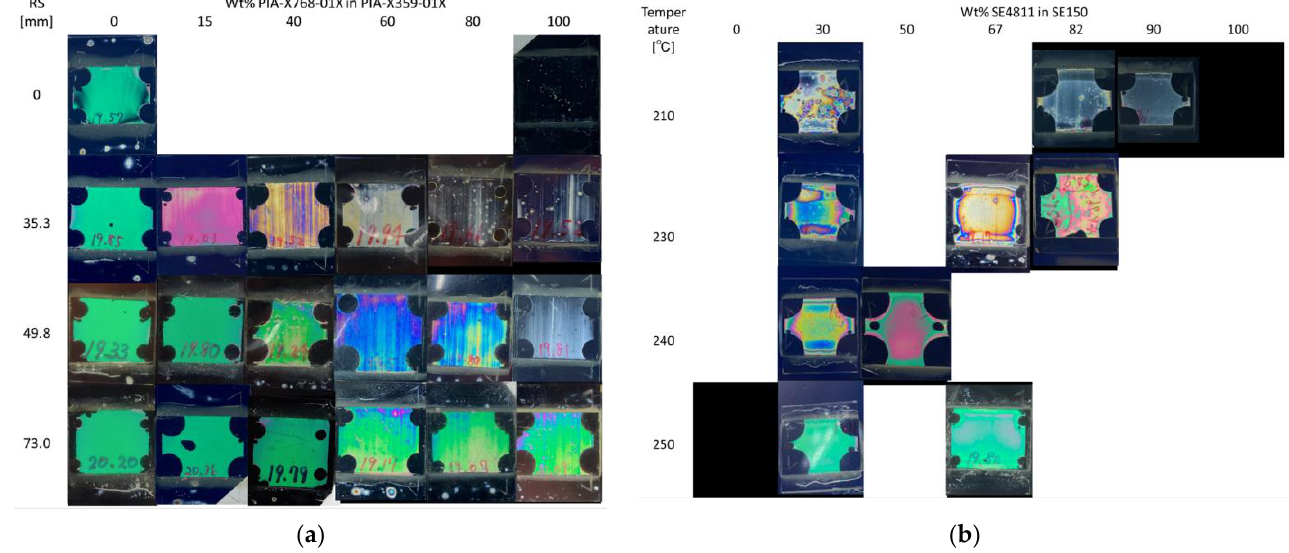
Figure 3. Cell photographs of blended alignment films with polarizers mounted on crossed nicols (45–135° relative to rubbing direction) for ( a ) PIA-X768-01X and PIA-X359-01X and ( b ) SE-4811 and SE-150.